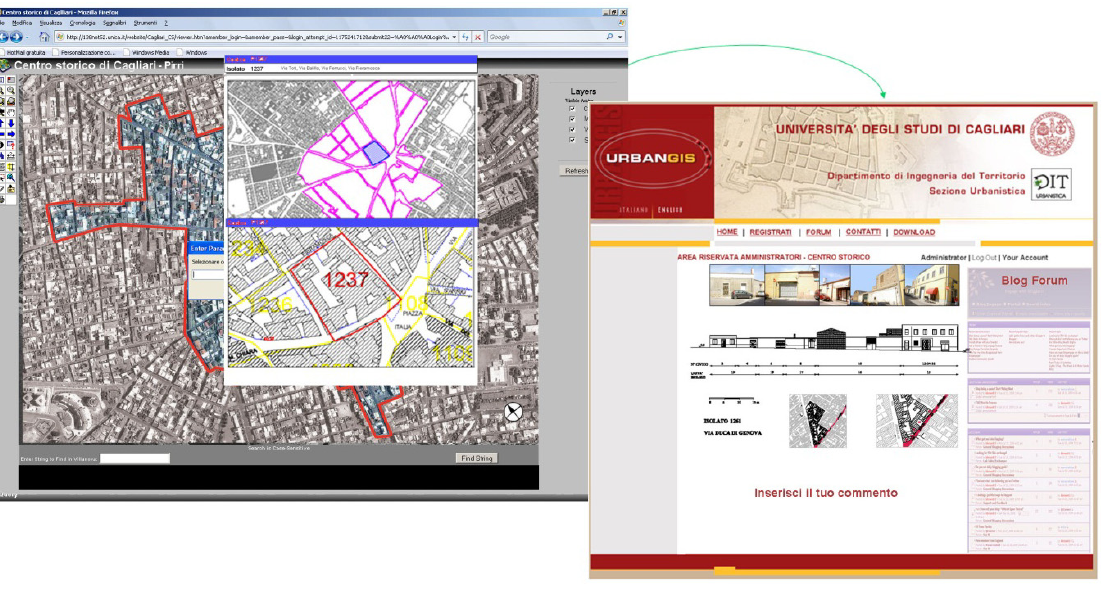
Figure 3. The structured WebGis: blog and forum